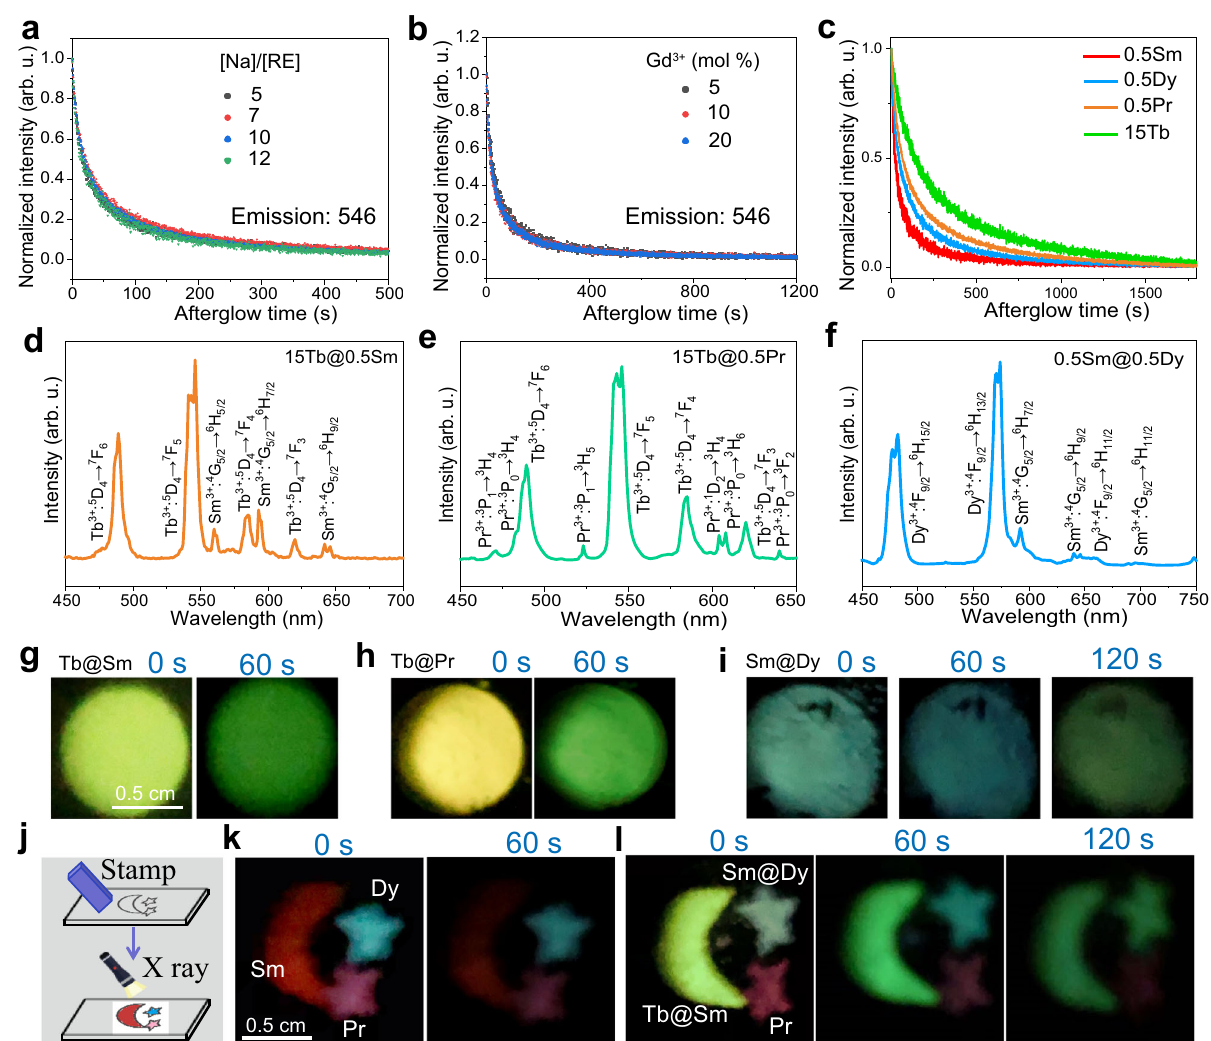
Fig. 4 | Engineering time-dependent multicolour afterglow evolution via edit- ingcore@shellarchitecture.a NormalizedXEAdecaycurvesoftheNaLuF 4 :15Gd/ 15Tb core-only NPs prepared with different [Na]/[RE]. b Normalized XEA decay curves of the NaLuF 4 : Gd/15Tb core-only NPs doped with different Gd 3+ ions con- centrations. c NormalizedXEAdecaycurvesoftheNaLuF 4 :15Gd/(0.5Pr,15Tb,0.5Dy or 0.5Sm) core-only NPs. XEOL spectra and corresponding XEA photographs with